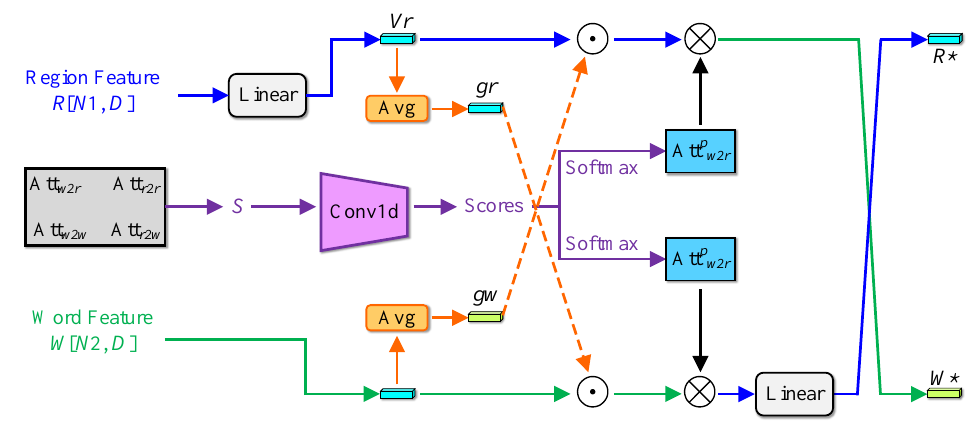
Figure 4. The path-wise attention (PA) block with the guard gate (orange marked). The specific calculation method of score is given by the